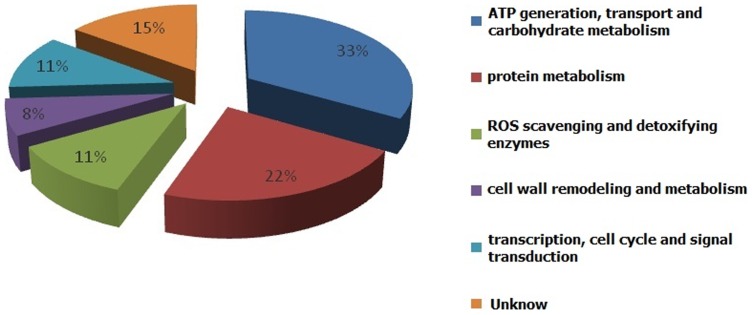
Functional categorization of different proteins. Digitals stand for the protein number of each functional category.